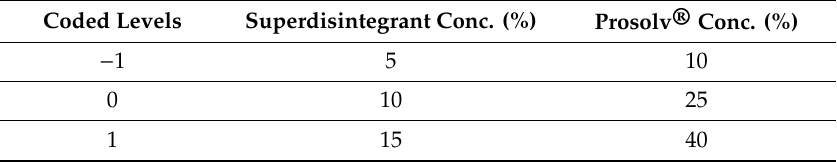
Table 6. Independent formulation variables and their levels used in experimental design. Coded Levels Superdisintegrant Conc. (%) Prosolv ® Conc. (%) − 1 5 10 0 10 25 1 15 40 − 1: factor at low level; 0: factor at medium level; 1: factor at high